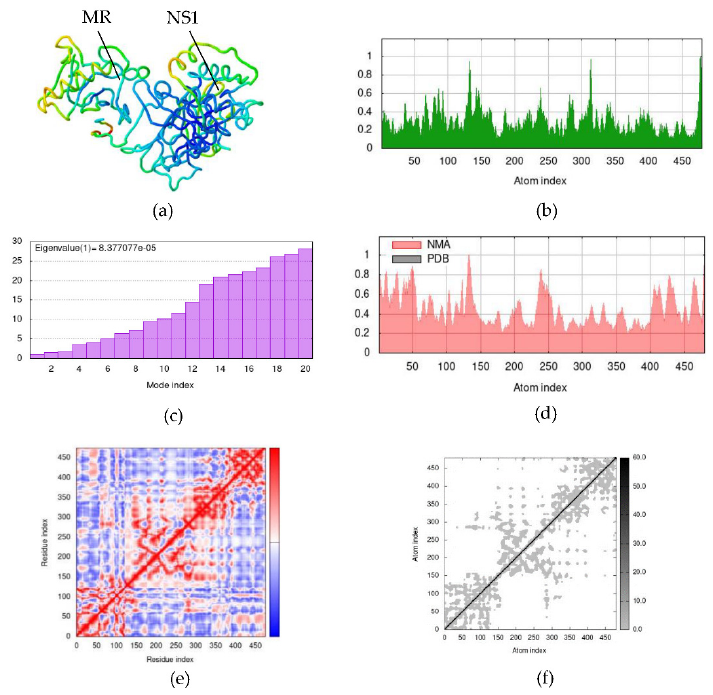
Figure 7 . Normal mode analysis (NMA) of NS1–MR docking complex by iMODs. ( a ) NS1 and MR docking complex; ( b ) main-chain deformability; ( c ) the eigenvalue; ( d ) B-factor values; ( e ) covariance map; ( f ) elastic network of model.